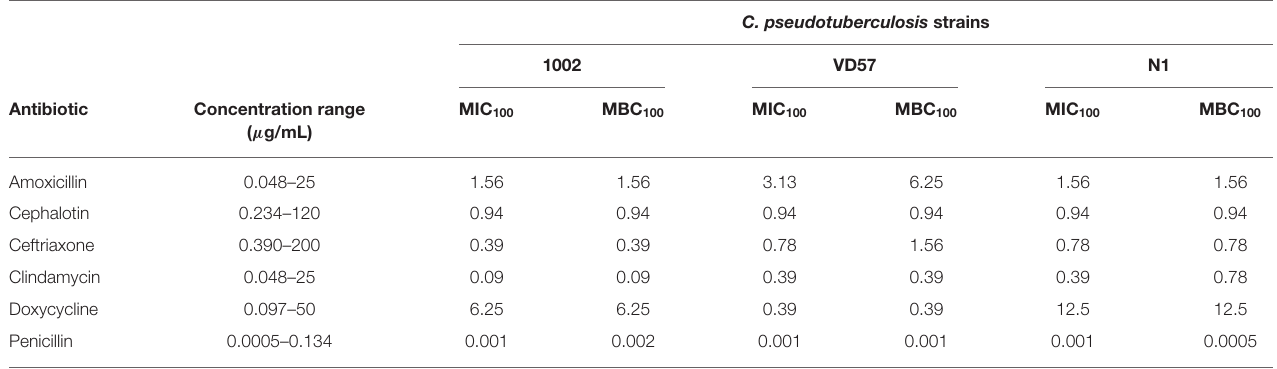
TABLE 3 | MIC 100 and MBC 100 of six antimicrobial agents against C. pseudotuberculosis isolates as determined by the broth microdilution